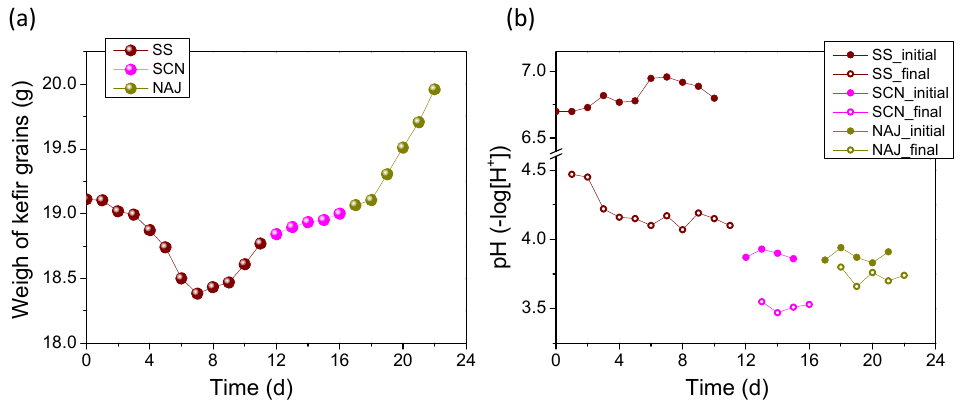
Figure 6. Weight change of kefir grains ( a ), pH variation ( b ), during the fermentation of sugary substrates at 24 h fermentation cycles (FC). SS, Sucrose solution; SCN, sour cherry nectar, NAJ, natural apple juice.